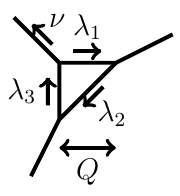
Figure 19 . A web diagram for the \half" of the conifold.